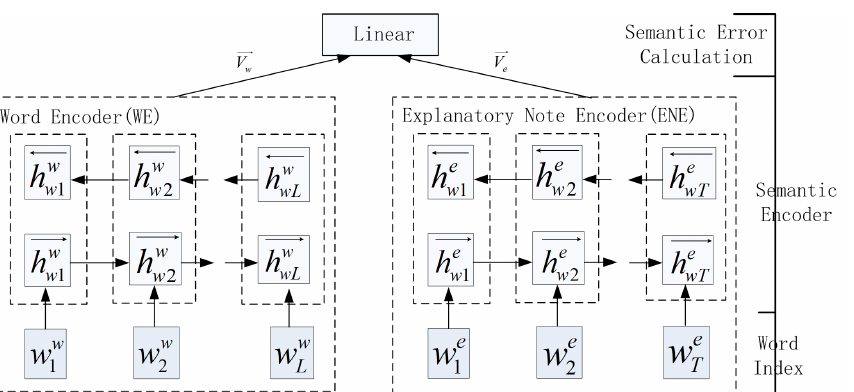
Figure 2. An infeasible semantics learning model composed of WE and ENE. The model aims to extract the semantics of words from the explanatory notes but